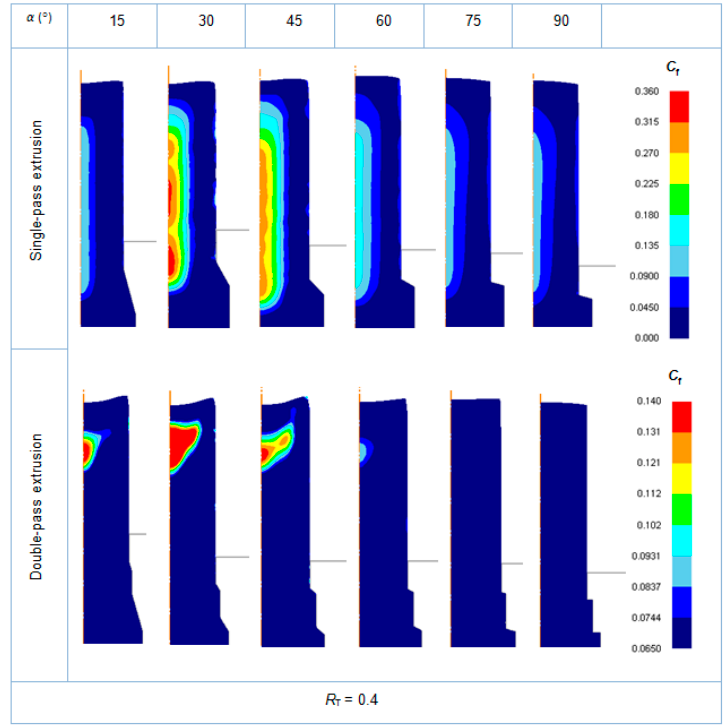
Figure 20. Comparison of damage ( C f ) induced with single-pass dies vs. the best configurations of double-pass dies with R T = 0.4.